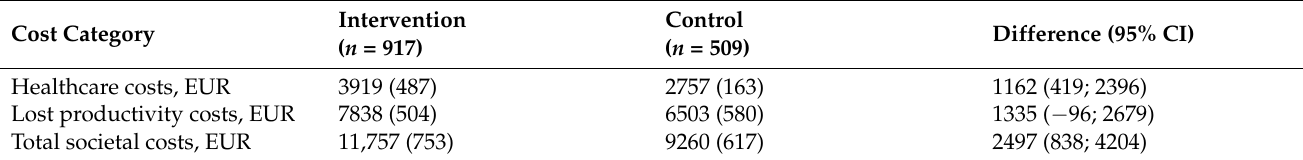
Table 2. Pooled mean costs and cost differences in the non-selective questionnaire